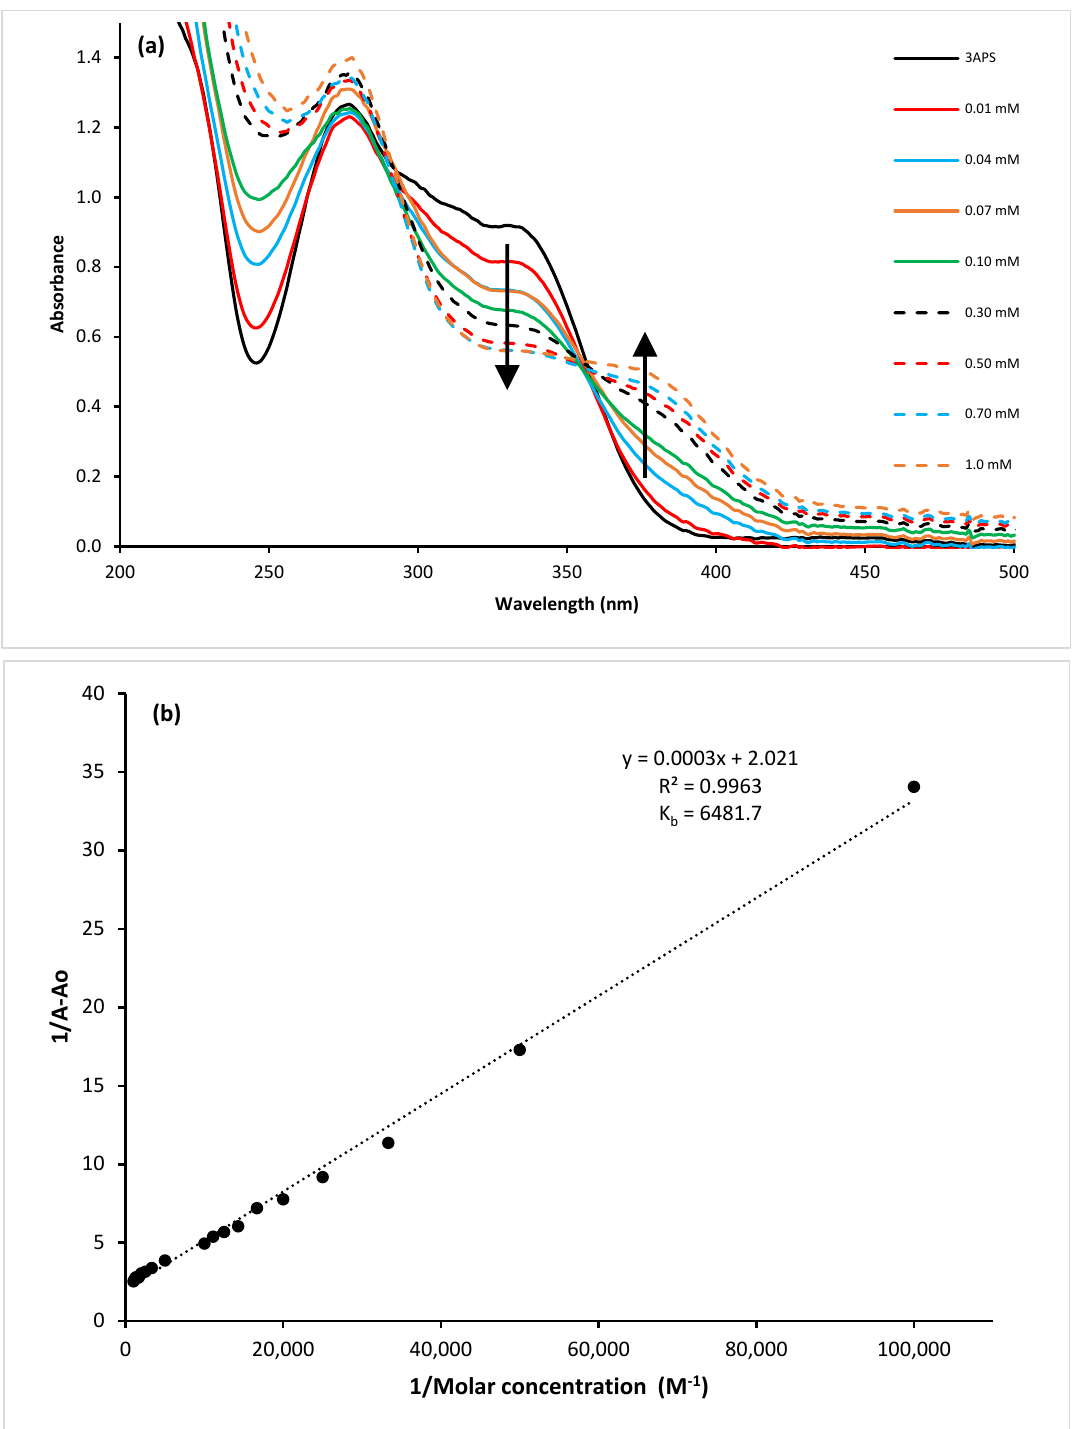
Figure 4. UV – VIS titration spectra of 3APS (1 × 10 − 5 M) with varying concentrations of Cu(II) solutions (5 × 10 − 6 – 1 × 10 − 4 M) in H 2 O – ACN (9:1) ( a ). In the Benesi – Hildebrand plot, A 0 is the absorbance